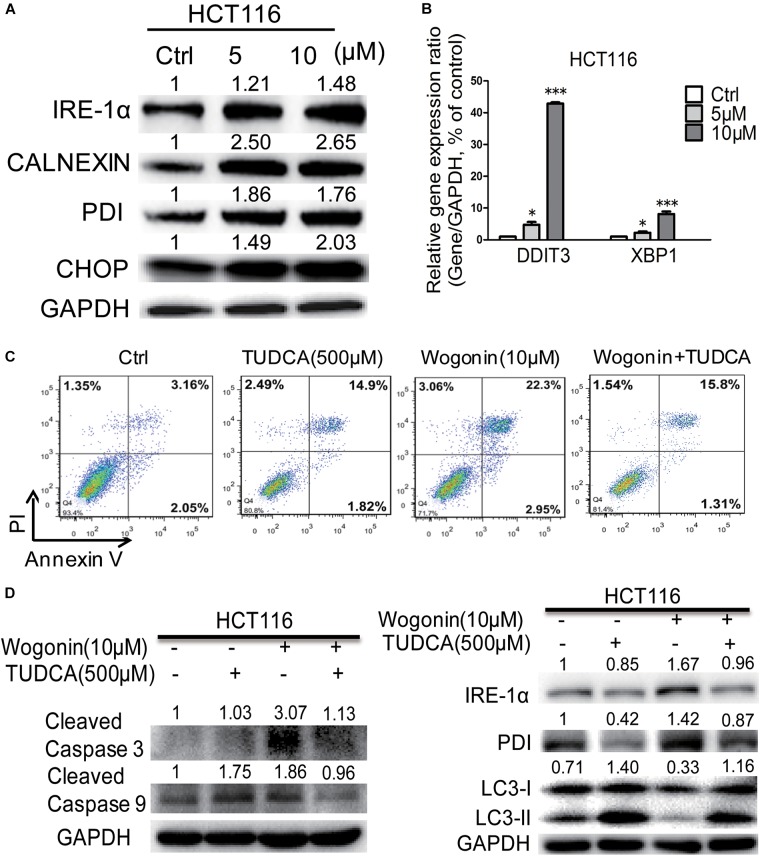
Wogonin caused apoptotic cell death through increased ER stress in human CRC HCT-116 cell. (A) IRE-1α, CHOP, PDI, and CALNEXIN protein levels in HCT-116 cells treated with wogonin and vesicle (0.1% DMSO) for 72 h were detected using western blot assay. The band intensities were quantified by Quantity One and represented as bar graph in the right panel. GAPDH was used as an internal control. (B) Gene expression of DDIT3 and XBP1 were determined by real-time PCR after treatments with indicated concentrations of wogonin for 72 h. GAPDH served as housekeeping gene. (C) Apoptotic effects in HCT-116 cells after wogonin treatment (10 μM) with/without TUDCA (500 μM) for 48 h, and the proportion of apoptotic cells was determined by flow cytometry using Annexin V/propidium iodide (PI) double staining. (D) Protein expression levels of cleaved caspase 3, cleaved caspase 9, IRE-1α, PDI, LC3-II to LC3-I in HCT-116 cells after wogonin treatment (10 μM) with/without TUDCA (500 μM) for 72 h. GAPDH was used as an equal loading control. Experiments were performed in triplicate and data represent as mean ± SD, significant difference versus control group, ∗P < 0.05; ∗∗∗P < 0.001.